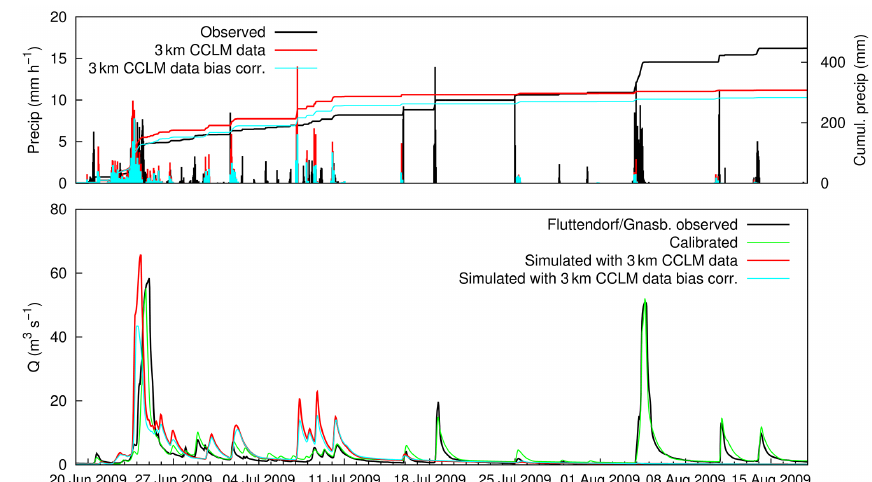
Figure 15. Run-off simulated with the uncorrected (1h rainfall sums) and bias-corrected (3h rainfall sums) 3km CCLM data for the period with the largest floods at the Fluttendorf/Gnasbach gauge. Above: catchment